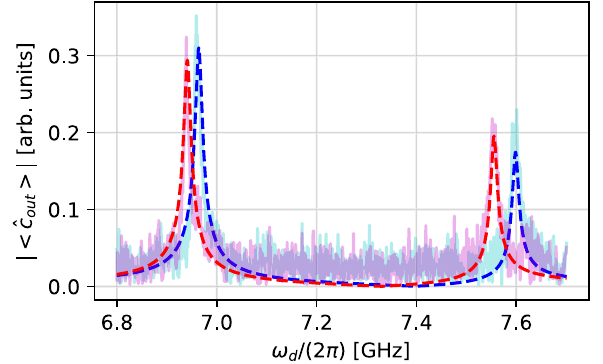
FIG. 3. Polariton spectroscopy via the transmitted amplitude of the cavity as a function of the driving frequency ω The resonances at lower and higher frequency correspond to the lower and upper polariton modes, respectively. In addition, both polariton resonances are cross-Kerr shifted depending on the prepared qubit state (ground j g i in blue and excited j e i in red). The highlighted red and blue lines correspond to the theoretical prediction in Eq. (7) with the parameters given in Table IV, valid for Φ ¼ 5 Φ 0